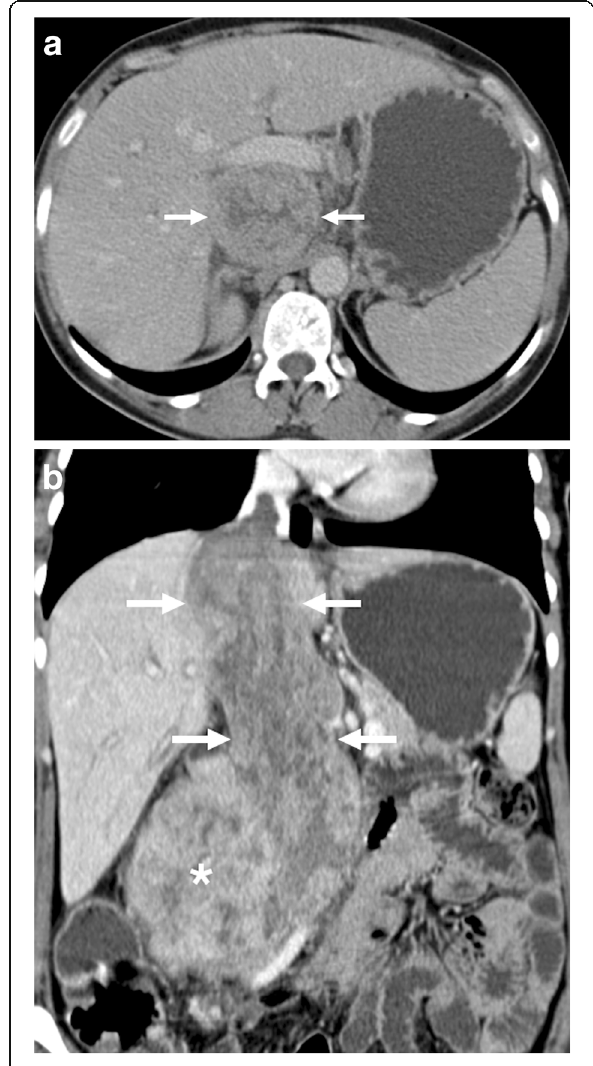
Fig. 8 A 35-year-old female with no significant past medical history presented with palpable mass in the abdomen and bilateral leg swelling. a Axial plane postcontrast CT image shows a contrast enhancing expansile mass within the IVC lumen (arrows). b Coronally reformatted postcontrast CT image shows the extension of the tumor along the trajectory of the IVC (arrows) with prominent extraluminal extension (asterisk). Biopsy confirmed leiomyosarcoma of the IVC